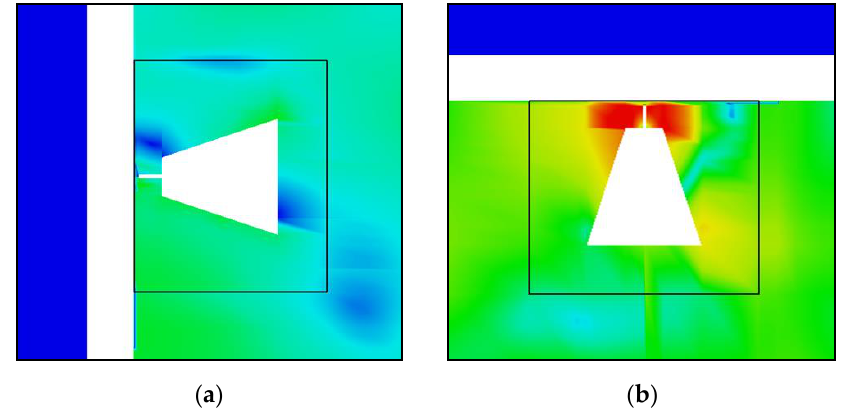
Figure 12. Electric field distribution on the first cutting plane at time t = 24 ns after PD source (red circle) trigger.